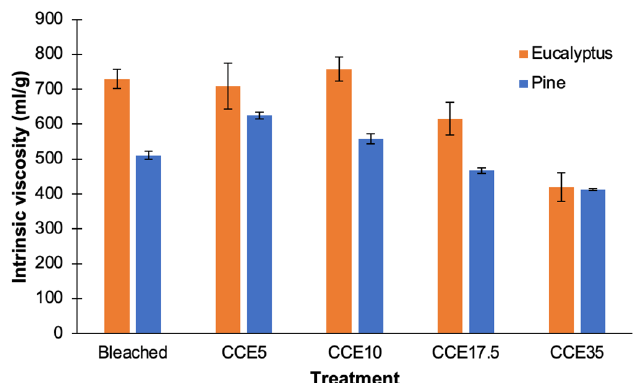
Figure 6. Intrinsic viscosity of bleached and CCE-treated kraft pulps from eucalyptus and